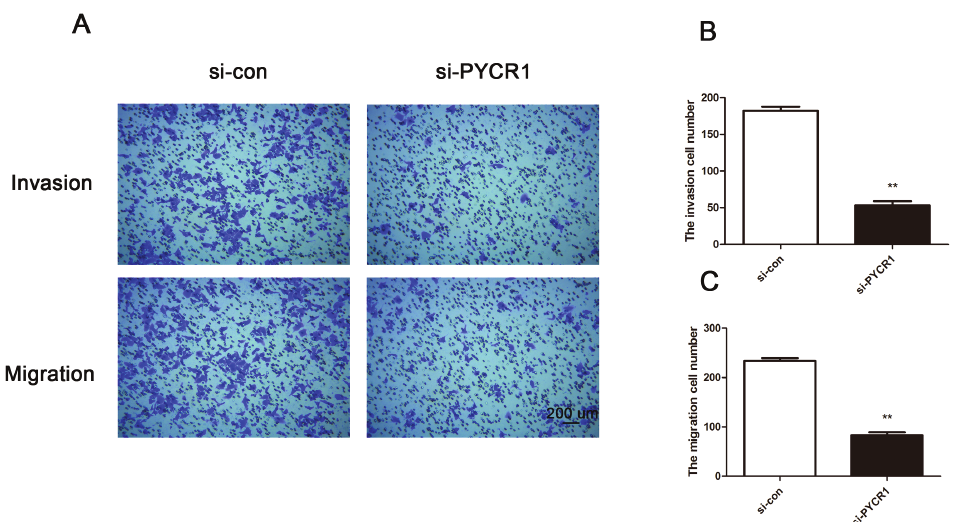
Figure 3: PYCR1 knockdown inhibits cell migration and invasion in Ketr-3 cells. (A) Transwell assays showed the difference of cell migration and invasion between si-con group and si-PYCR1 group. (B) and (C) The migratory and invasive cells were calculated. Bar = 200 μm. Every experiment was conducted three times. (**P <